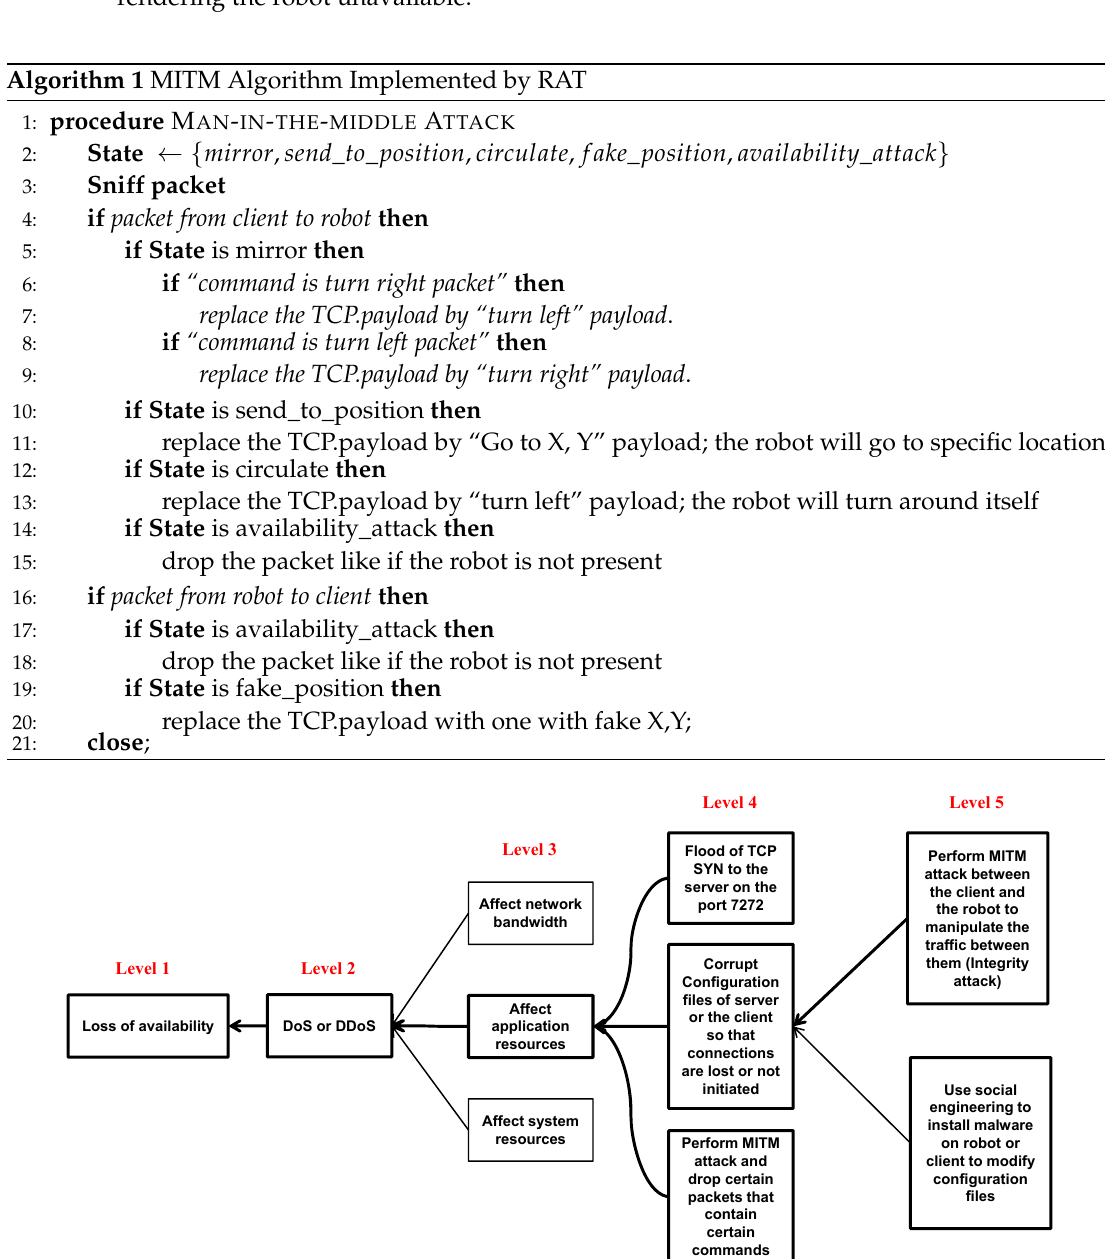
Figure 7. Availability attack